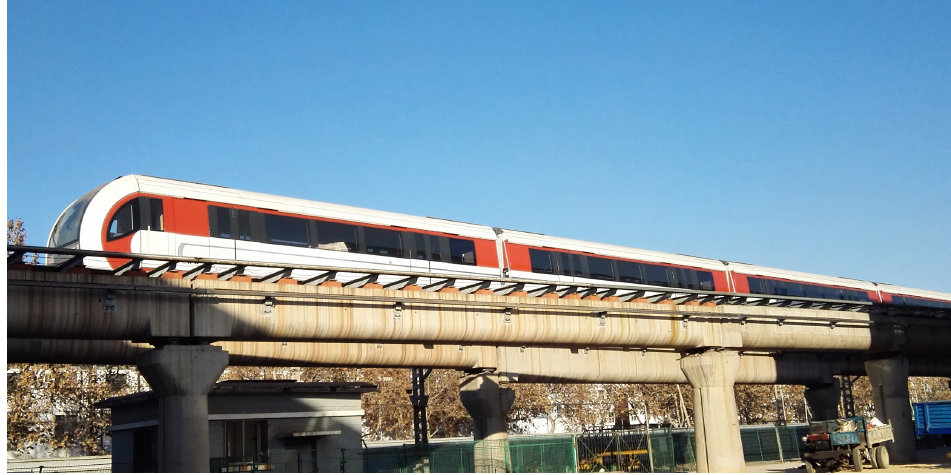
Figure 5. Tangshan maglev experimental line.